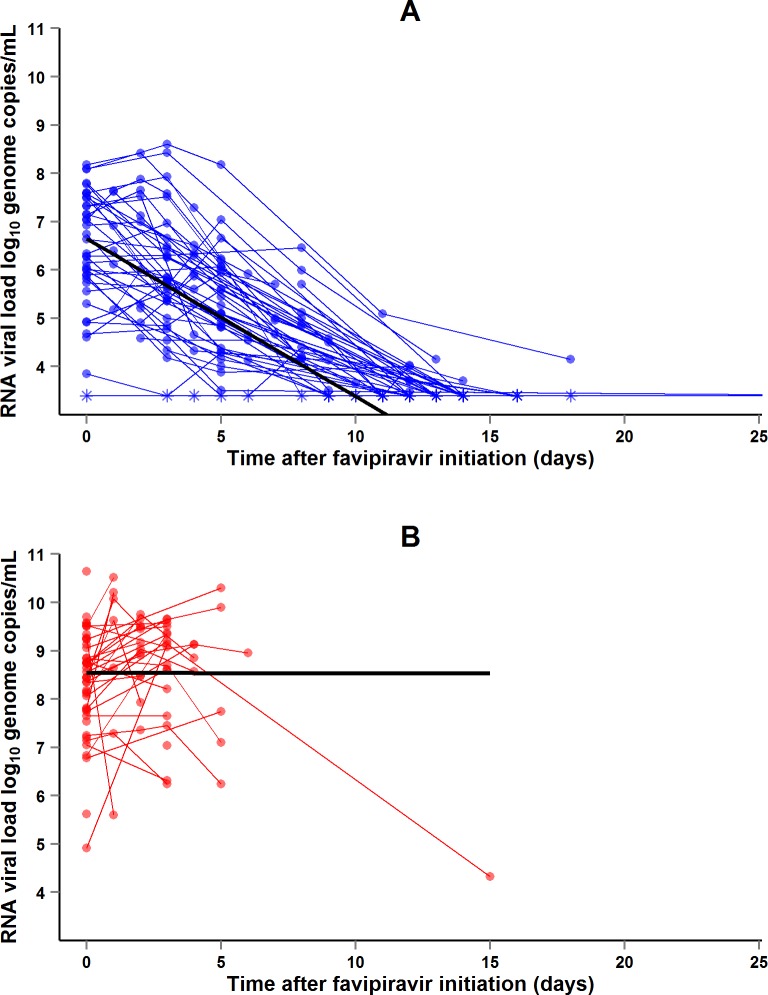
JIKI trial: evolution of RNA viral load in adolescents and adults.(A) Evolution of RNA viral load in adolescents and adults who survived. The x-axis represents the time since favipiravir initiation (day 0). Each blue line represents one patient (n = 48). Circles represent baseline and follow-up values. Asterisks represent values under the limit of detection (3.4 log10 copies/ml). The black line represents the mean log10 viral load decline estimated from a linear mixed effect model. The mean initial viral load was estimated at 6.65 log10 copies/ml (SD 0.86), and the mean slope of viral load evolution at −0.33 log10 copies/ml (SD 0.03) per day of follow-up. (B) Evolution of RNA viral load in adolescents and adults who died. The x-axis represents the time since favipiravir initiation (day 0). Each red line represents one patient (n = 49). Circles represent baseline and follow-up values. The black line represents the mean log10 viral load evolution estimated from a linear mixed effect model. The mean initial viral load was estimated at 8.54 log10 copies/ml (SD 0.21), and the mean slope of viral load evolution at −0.001 log10 copies/ml (SD 0.15) per day of follow-up.